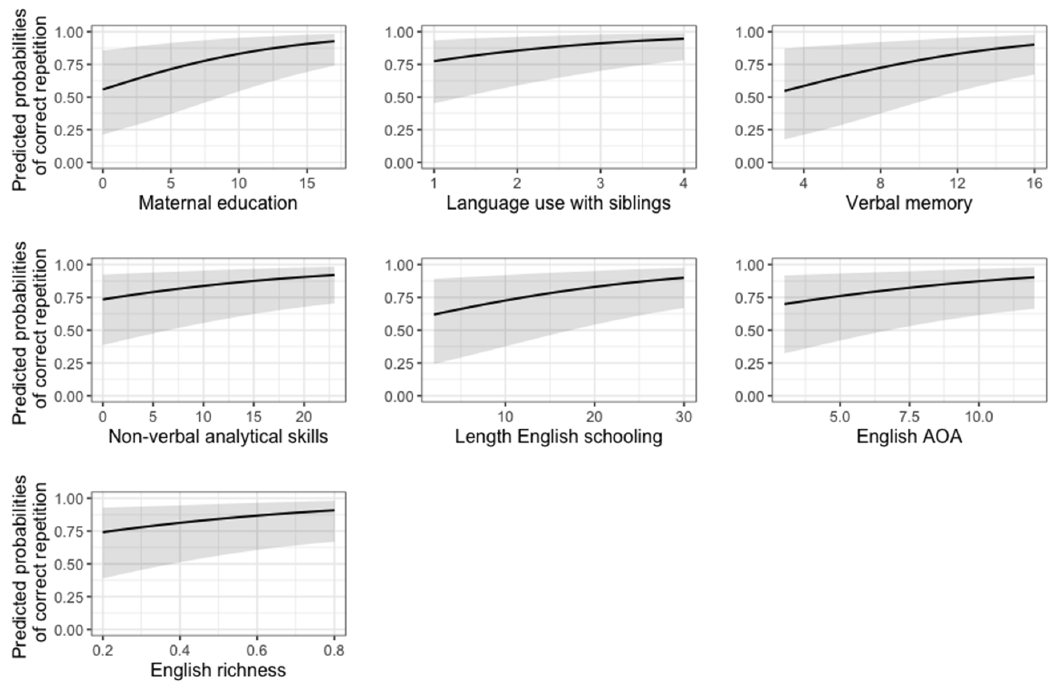
Figure 5. Predicted probabilities of a correct response given each fixed effect in the optimal model of English T1, predicting correct repetition of target morphosyntactic structure.